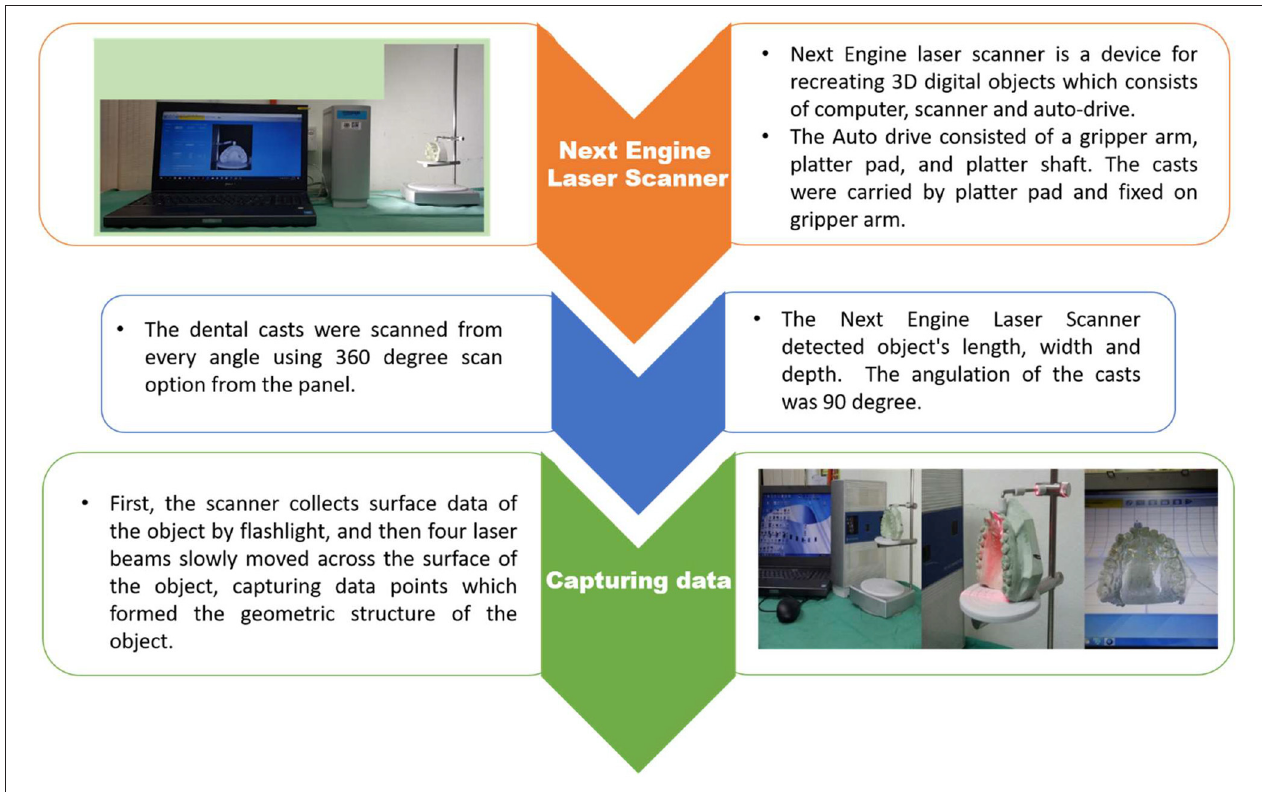
FIGURE 3 | Conversion of the dental casts into